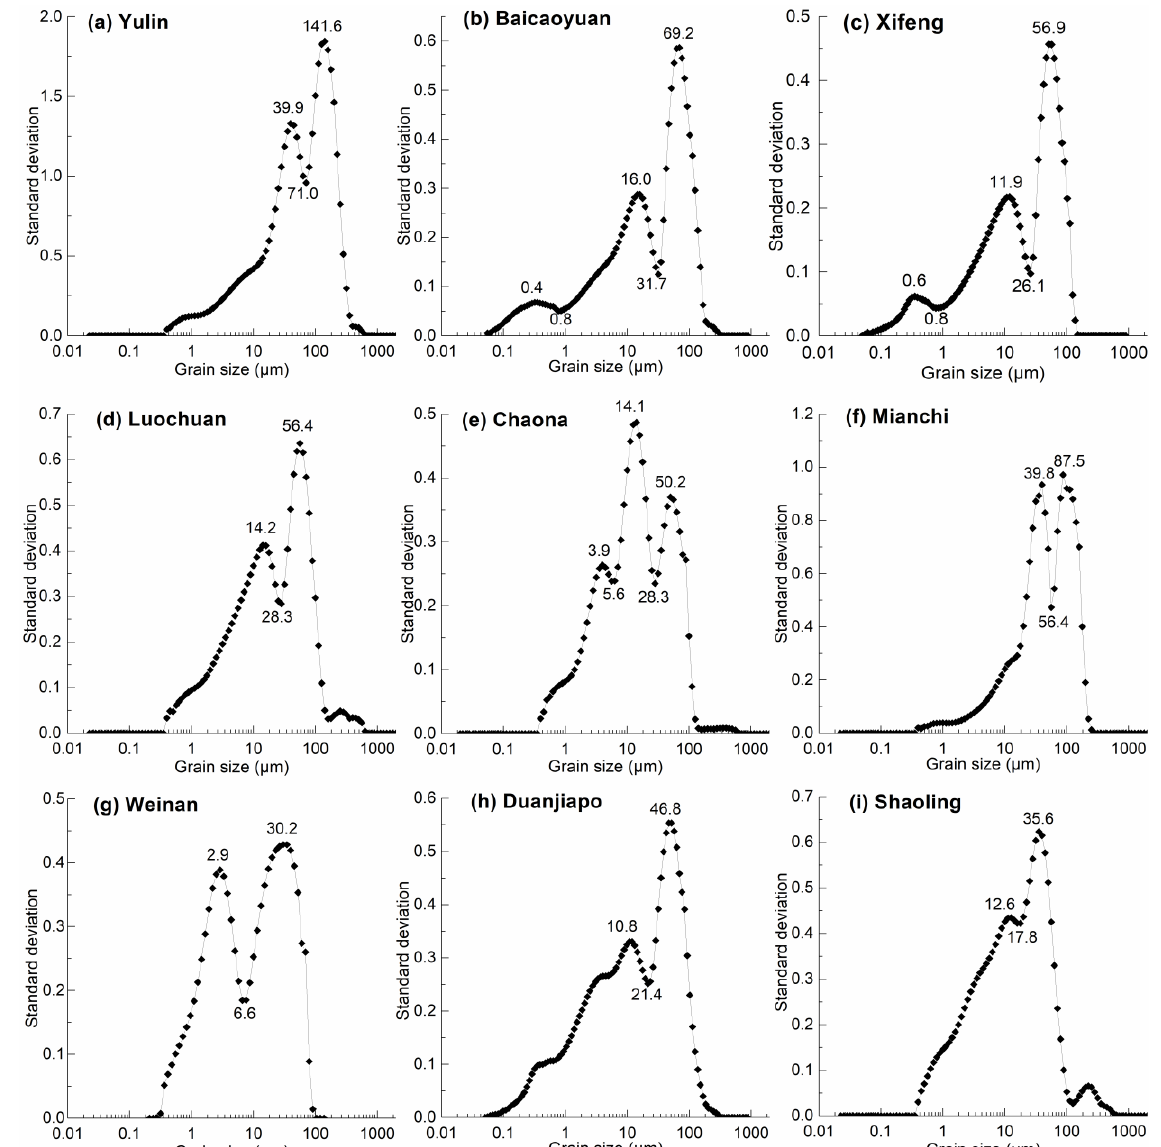
Figure 2. Grain-size classes vs. standard deviation curves of nine last glacial loess sections ( a – i ) on Chinese Loess Plateau.